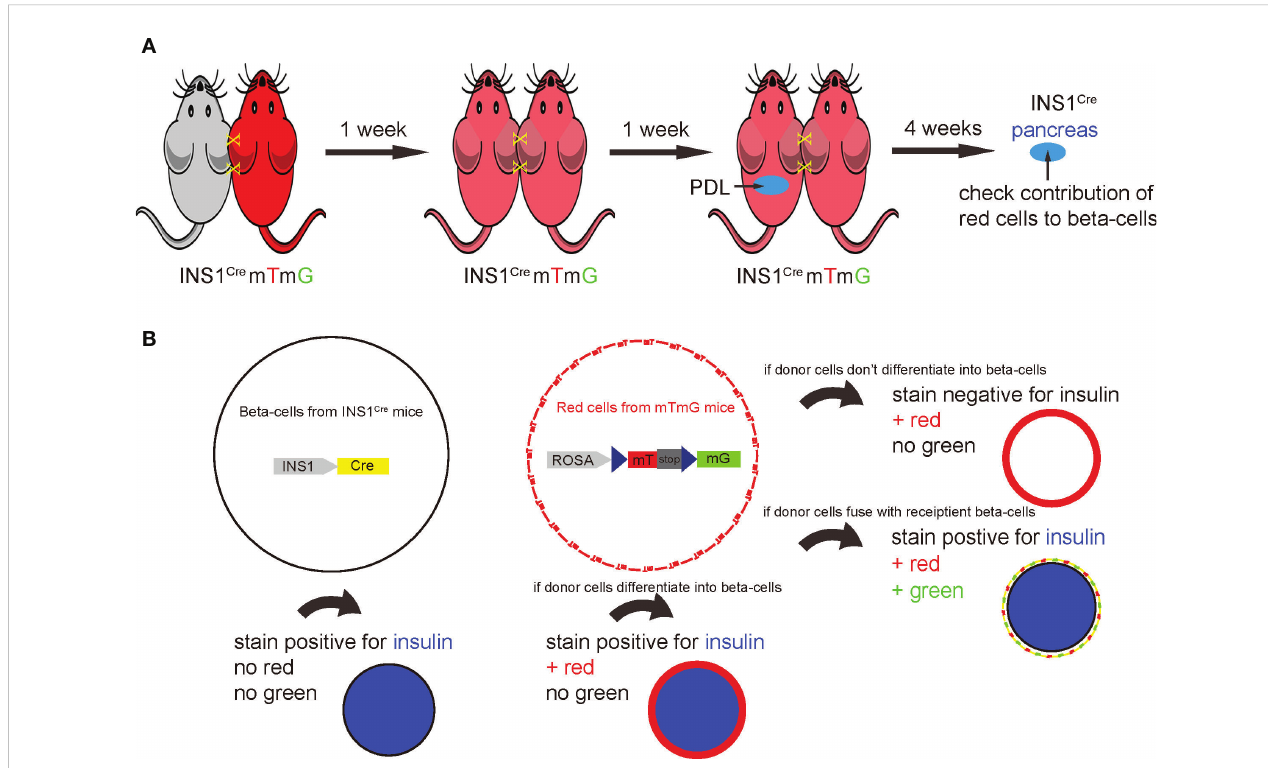
FIGURE 1 Establishment of an irradiation-free parabiosis model to track the fate of the BMCs in PDL pancreas. (A) Schematic to show parabiosis of a ROSA-mTmG red fl uorescent mouse to an INS1 Cre knock-in mouse to establish a chimeric circulation. once the chimerism was established, PDL was performed on the INS1 Cre knock-in mice. Afterwards, the contribution of mT red cells derived from ROSA-mTmG mice to the beta-cell population in the PDL-INS1 Cre knock-in mice was assessed. (B) This system also allows detection of cell fusion, the occurrence of which could result in recombination of the loxp locus of ROSA-mTmG mice by the activated Cre recombinase in beta-cells from the INS1 Cre knock-in mice. The examination of insulin immunostaining along with detection of the mT red or mG green fl uorescence of the cells together allows for the determination of the contribution of BMCs to beta- cells in the PDL-treated in fl amed pancreas. The pre-existing beta-cells will stain positive for insulin, but negative for green mG or red mT fl uorescence. If red cells from ROSA-mTmG mice do not stain positive for insulin, they do not directly contribute to beta-cells. If cells from ROSA-mTmG mice stain positive for insulin, but remain red and do not become green fl uorescent, they directly contributed to beta-cells. If cells from ROSA-mTmG mice stain positive for insulin, but lose red fl uorescent and become green, they must have fused with pre-existing